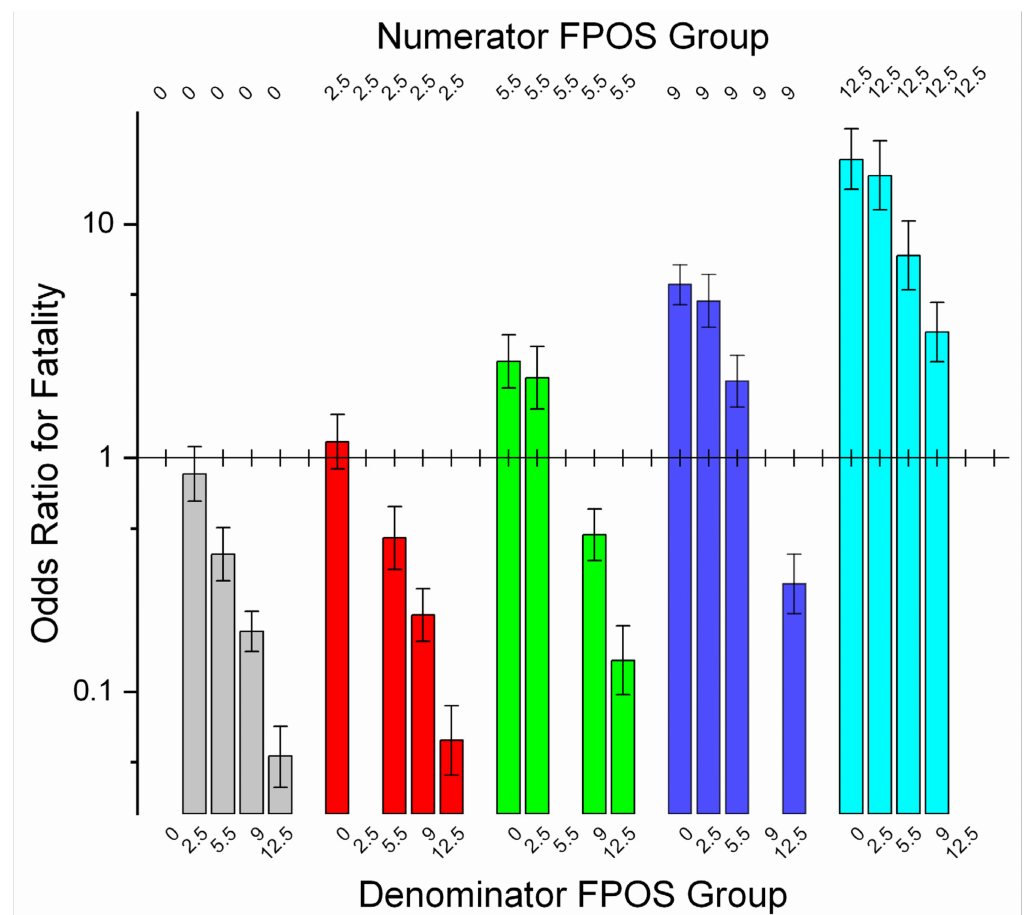
Figure 3. Contrasts between FPOS (finish position) groups for combined race- and workout-event data for Ontario Thoroughbred racehorses for 2003–2015, unit of interest—work-event, and showing odds ratios (OR) for fatality between groups together with their 95% confidence intervals. For OR values above 1, the numerator odds of fatality are higher than the denominator odds. Differences were greatest between FPOS 12.5 (race) and FPOS 0 (workouts, OR = 18.868, 14.085–25.641). Workouts and FPOS 2.5 did not differ. This pattern reflects, in part, increasing liability for late-finishing horses with increasing field size. Confidence intervals that include 1.0 are non-significant. (FPOS 0—workout event; 2.5—finish positions 1–4; 5.5—positions 5 and 6; 9—positions 7–11; 12.5—positions greater than 11). (Note log scale on y